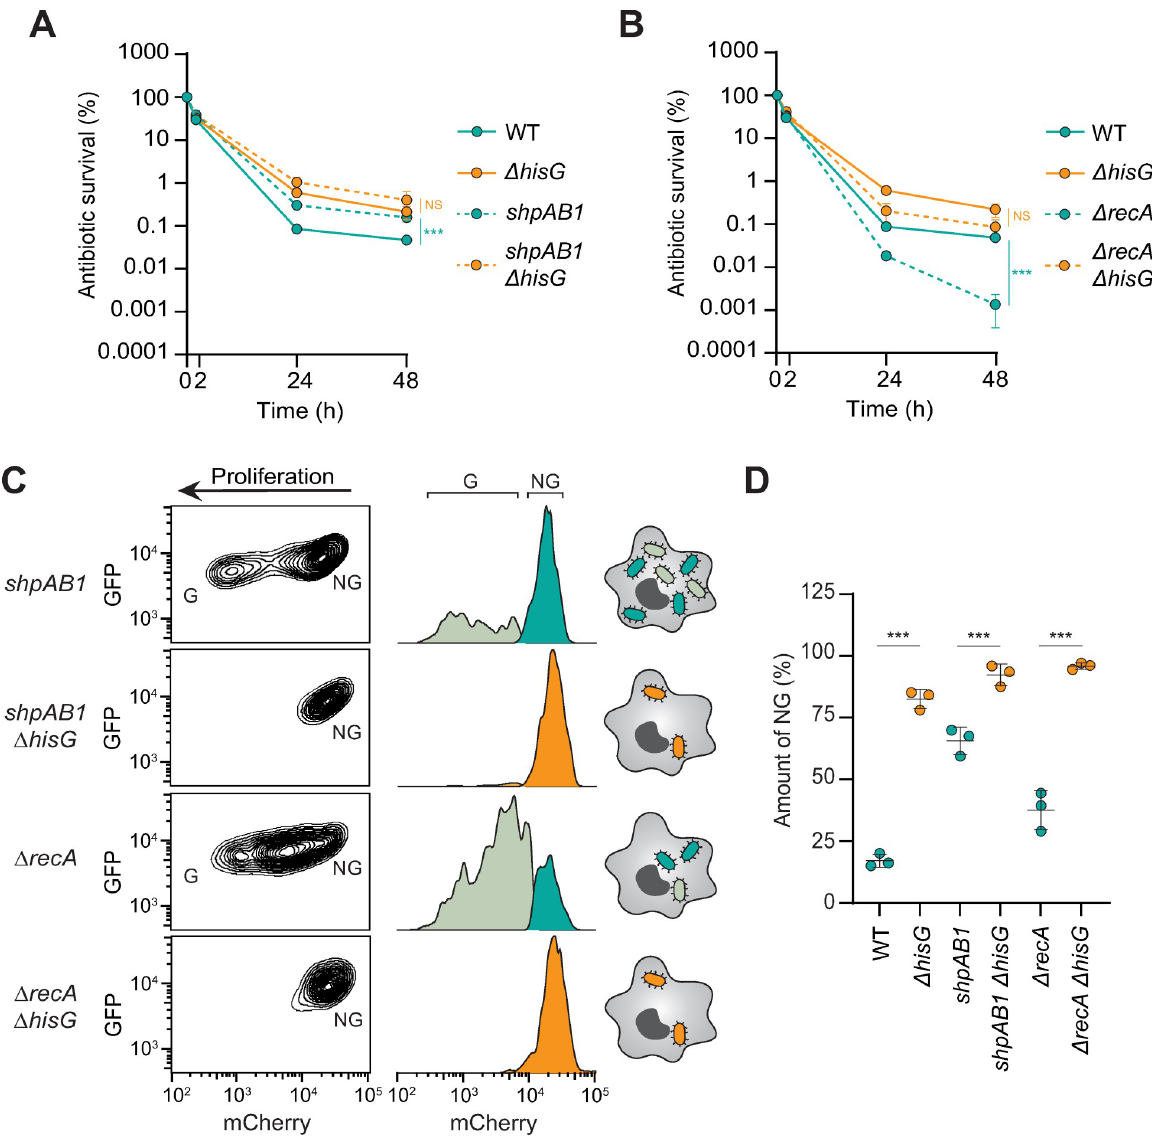
Fig 4. Tolerance can mask persister determinants during macrophage infection. ( A-B ) CFU enumeration of survival of the WT, Δ hisG , shpAB1 , shpAB1 Δ hisG , Δ recA and Δ recA Δ hisG Salmonella strains in BMDMs treated with cefotaxime and in absence of histidine. ( C ) Representative flow cytometry contour (left) and histogram plots (right) of the shpAB1 , shpAB1 Δ hisG , Δ recA and Δ recA Δ hisG strains extracted from infected BMDM after 16 h of gentamicin. G, growers and NG, non-growers. ( D ) Quantification of the non-grower fraction for each strain represented in panel C . Data represent the mean and SD of three biological repeats. Data were compared using one way ANOVA with Tukey’s multiple-comparison test, ��� p < 0.001; NS, not significant. Of note, WT and Δ hisG data are the same on panel A and B as all experiments were conducted in parallel. Auxotrophic strains are depicted in orange, prototrophic in turquoise. (Figs 5D, S4A and S4B). Because of its inability to colonize in the presence of the WT strain, the Δ hisG mutant displayed no antibiotic survival advantage in presence of antibiotics (Figs 5D, S4A, S4B and S5A). In contrast to macrophages where the intracellular proliferation of WT and the shpAB1 strain were comparable, we determined that the WT was more competi- tive in mice than the shpAB1 strain in the absence of antibiotic treatment (Figs 5E, S4C, S4D and S5B). However, the lower abundance of the shpAB1 strain in all tested organs during the